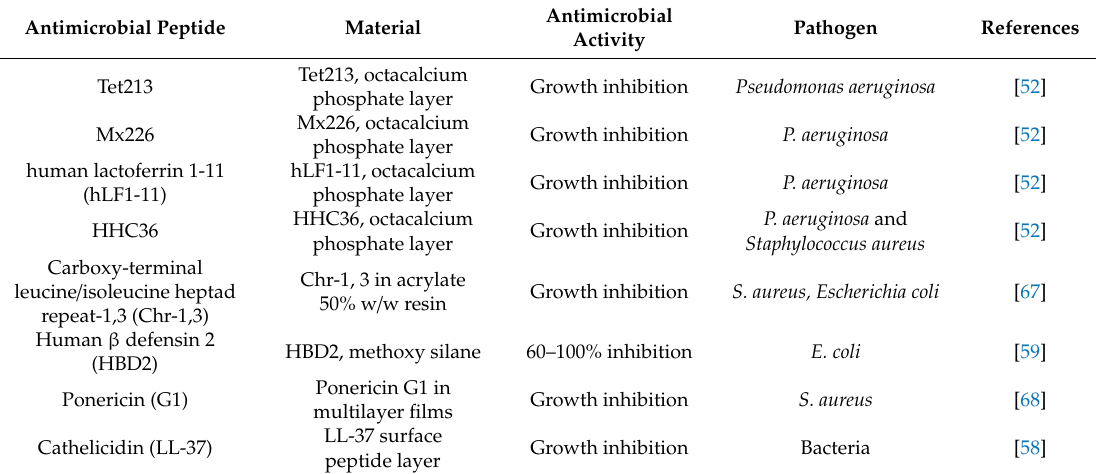
Table 4. Antimicrobial peptides used in bioactive coatings and their antimicrobial activities. Antimicrobial